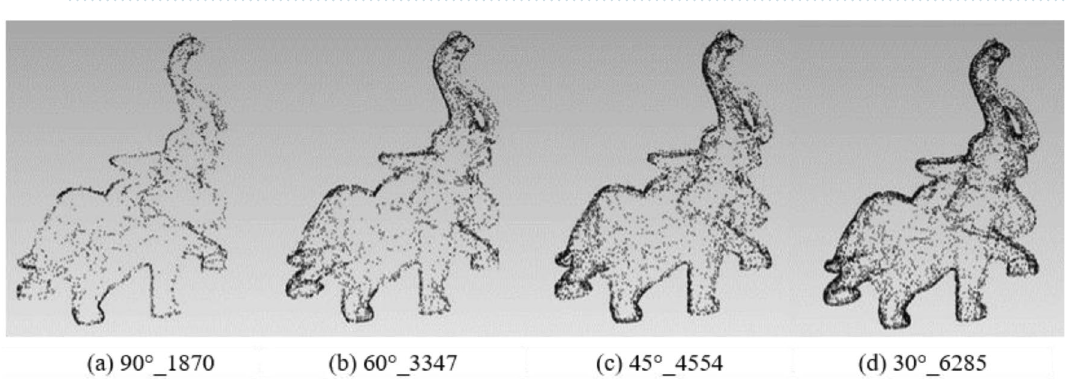
Figure 6. The point cloud with different numbers of feature points extracted with different angles for Bunny.